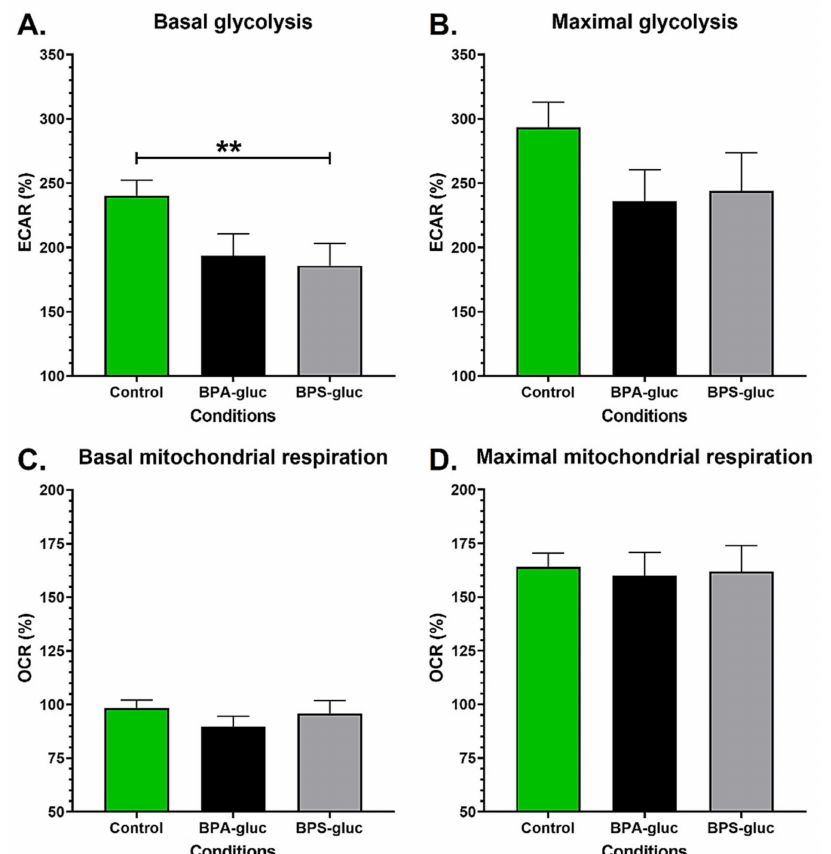
Figure 1. Chronic exposure to physiological concentrations of BPS glucuronidated metabolites decreases the basal glycolytic capacity of normal urothelial cells. ( A , B ) ECAR and ( C , D ) OCR were determined using the XFe96 Extracellular Flux Analyzer of normal urothelial cells (UCs) with or without chronic exposure to physiological concentrations of BPA-gluc or BPS-gluc to establish ( A ) basal glycolytic capacity, ( B ) maximal glycolytic capacity, ( C ) basal mitochondrial respiration and ( D ) maximal mitochondrial capacity. Analyses represent the combined results for two populations of normal urothelial cells (UC1 and UC2). Data are presented as the mean ± SEM and displayed as percentages of controls (i.e., untreated condition) (n ≥ 3, N = 4). The baseline (100%) was established before injections (see Figure S1). ** p < 0.01 by Mann–Whitney